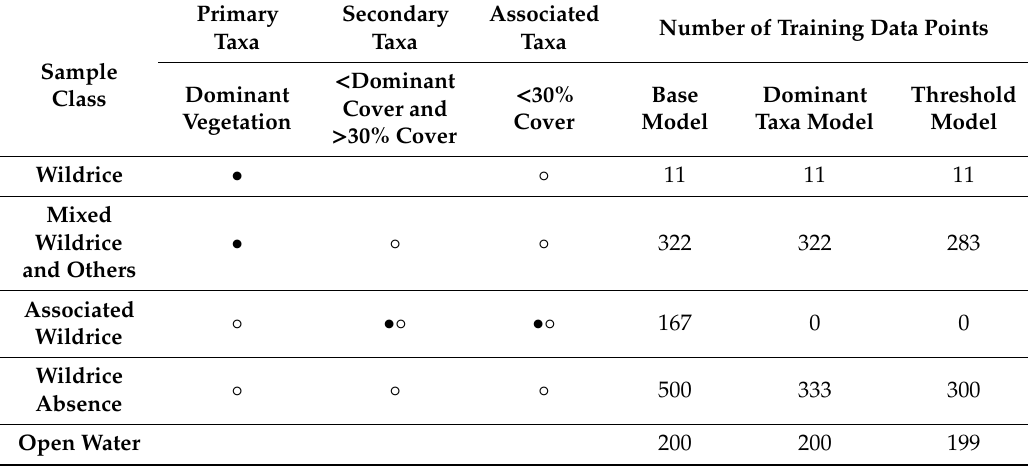
Table 1. Training and Validation Data Descriptions: Shows point classes, the taxa included in each class, and the number of sample points used to train each